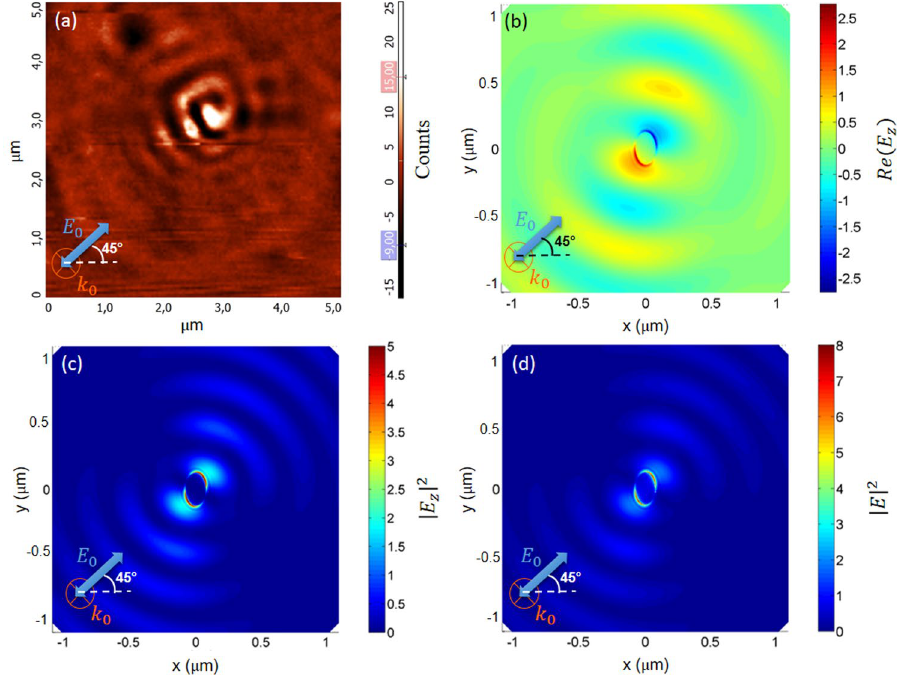
Figure 2. ( a ) SNOM image (scan area 5 μ m × 5 μ m) performed using an incident beam at λ exc = 632 nm with normal incidence and linear polarization at 45° on an elliptical nanohole in a thin gold film. The second polarizer is orthogonal respect to the first one (#1 ⊥ #2). Numerical results: ( b ) Near-field intensity distribution of Re ( E z ) around the elliptical nanohole illuminated by a plane wave at λ = 632 nm, at 2 nm from the metal surface. Simulations are performed by finite element method (FEM) simulation. Size of nanohole: major axis a = 130 nm, minor axis b = 80 nm. ( c ) Near-field intensity distribution of the z-component of the electric field E z 2 around the elliptical nanohole illuminated by a plane wave at λ exc = 632 nm, at 2 nm from the metal surface. ( d ) Near-field intensity distribution of the total electric field E 2 around the elliptical nanohole illuminated by a plane wave at λ exc = 632 nm, at 2 nm from the metal